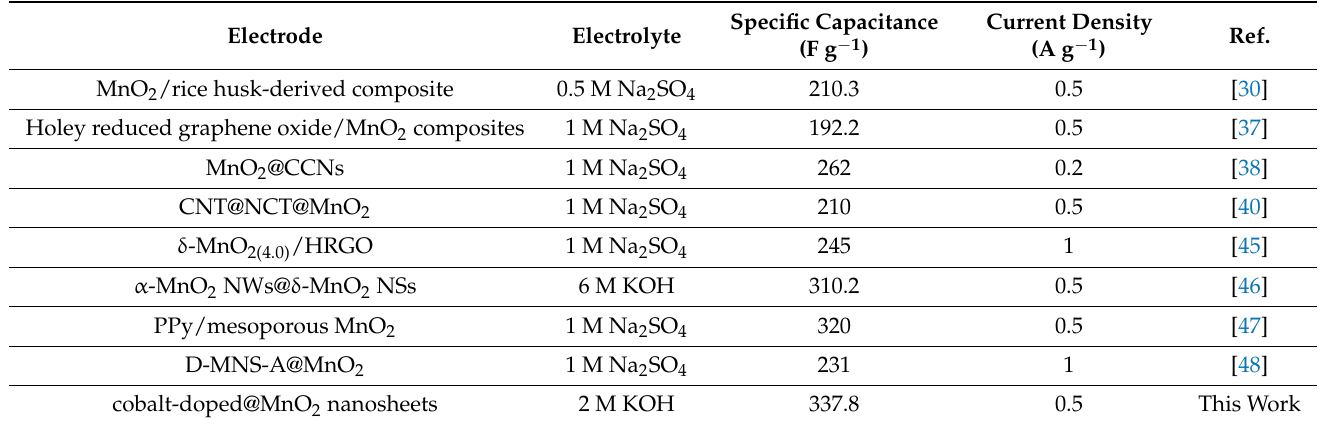
Table 1. MnO 2 composite electrode performance comparison over the last five years. Electrode